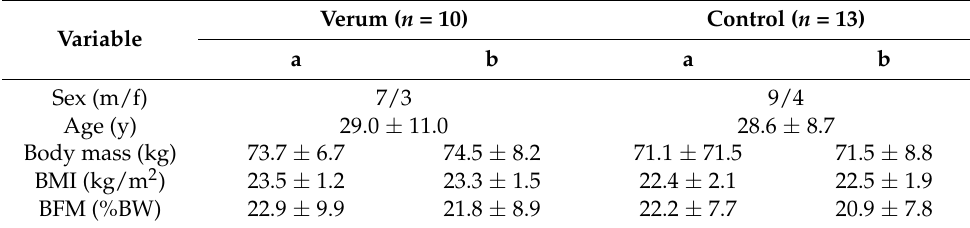
Table 1. Basic and anthropometric characteristics of the study groups (verum, control) before (time point a) and after the 3 months intervention period (time point b).